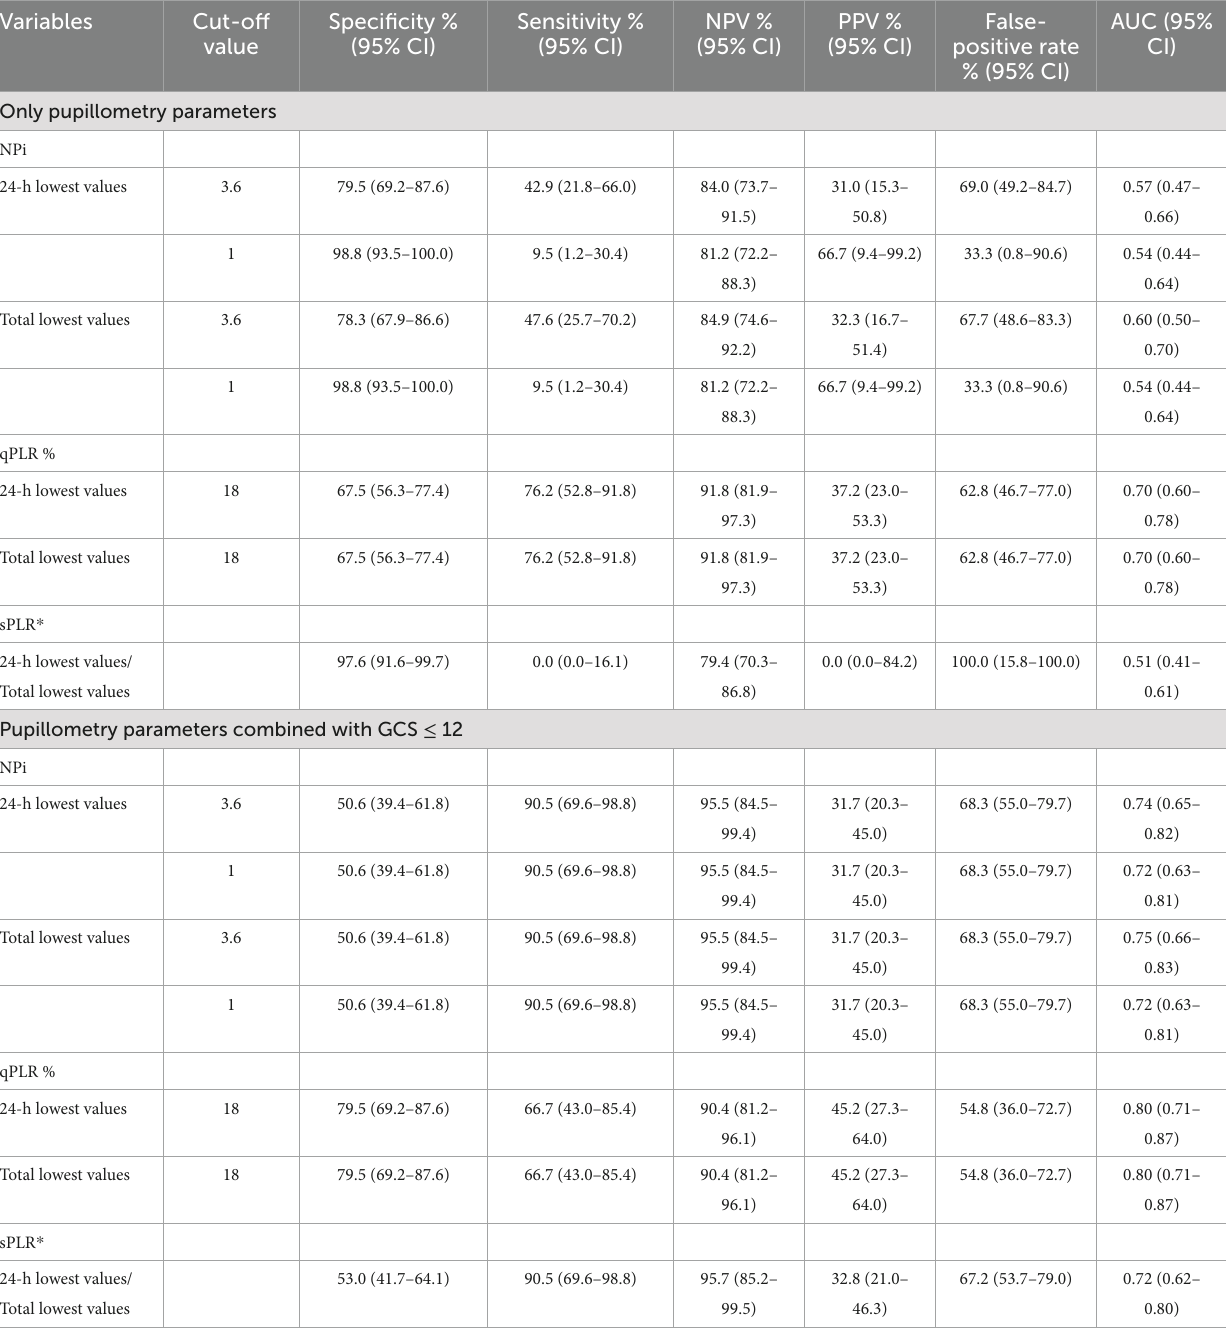
TABLE 4 Prediction of poor neurocognitive outcome at 1